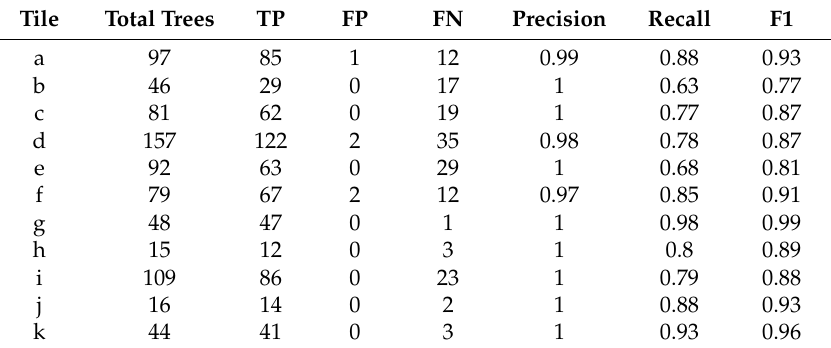
Table 5. Evaluation metrics for the instance of Mask R-CNN trained with the COCO pretrained network where all layers were adjusted during training. TP = true positive; FP = false positive; FN = false negative.